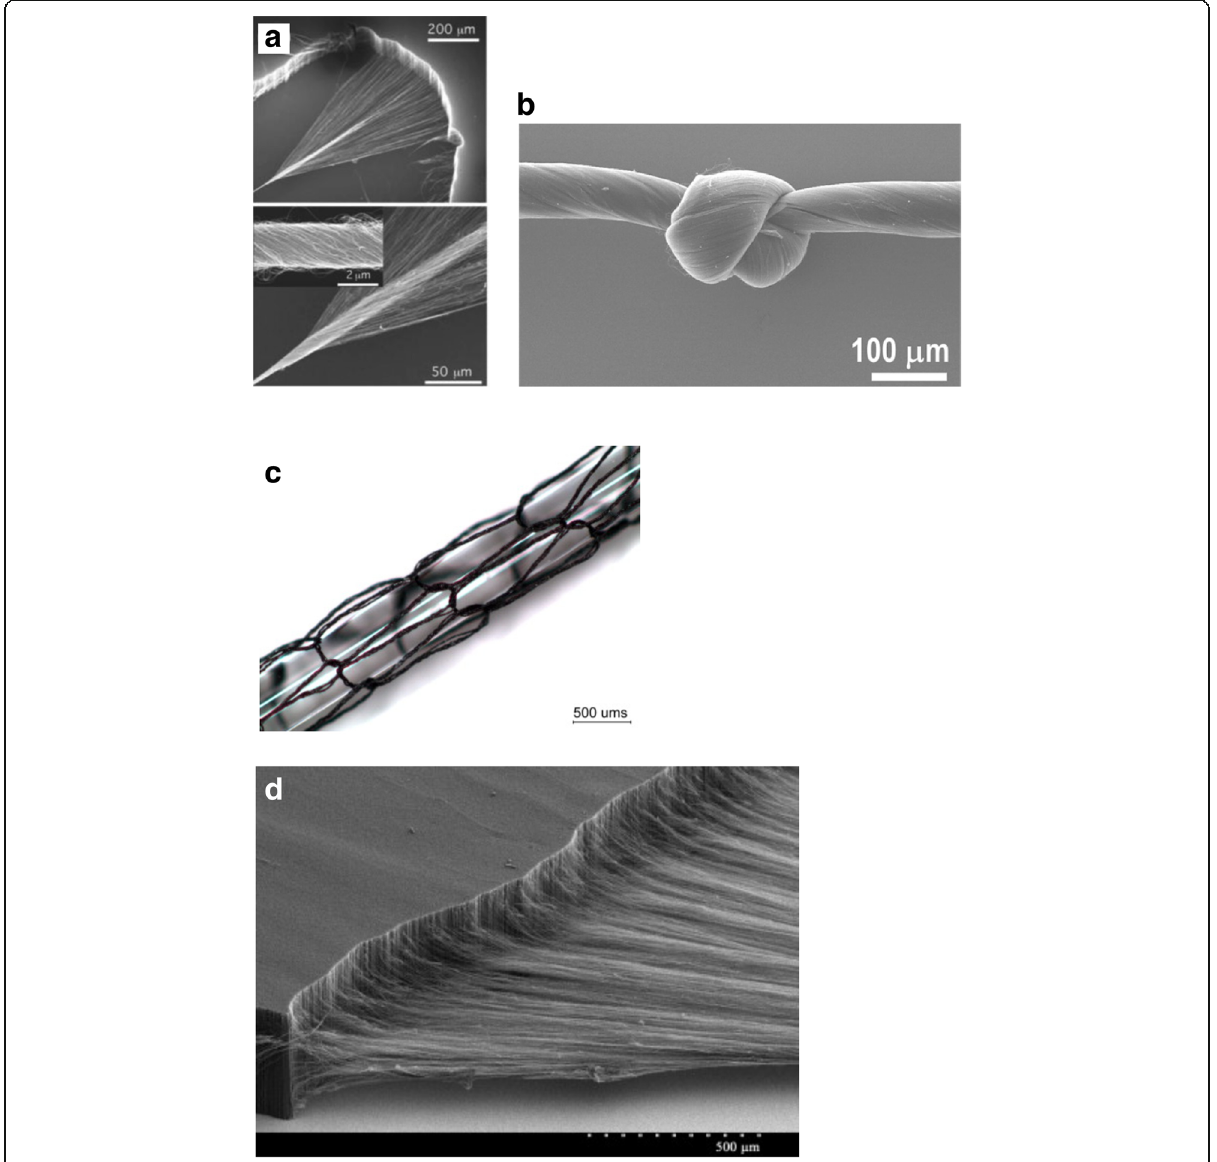
Fig. 37 SEM and optical images of CNT yarns. a SEM image of a part of CNT yarn from the nanotube forest being drawn and twisted. Dry spinning of the CNT yarns from the forests (vertically grown CNT array) is shown. Adapted from [266]. b SEM image of a knotted CNT yarn. Adapted from [265]. c Optical image of a MWCNT knitted yarn, with a glass rod through the center. The average diameter of the MWCNT knitted yarn was measured to be 34.09± 2.86 μ m. Adapted from [267]. d SEM image of MWCNTs in a forest being drawn into a sheet. Adapted from